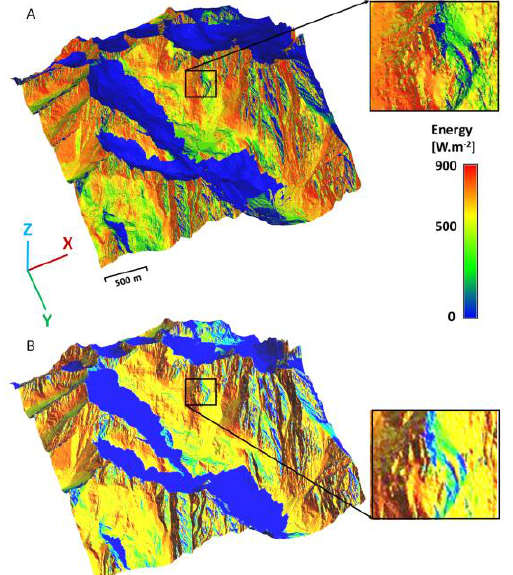
Figure 4. Solar radiation modelling for 15 September at 15 o'clock using (A) v3.sun module and (B) r.sun module. As input data of DTM were used (A) TIN model and (B) grid.